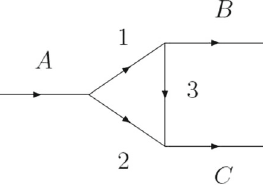
Fig. 1 Triangle diagram for the reaction A → BC , possibly yielding a triangle singularity